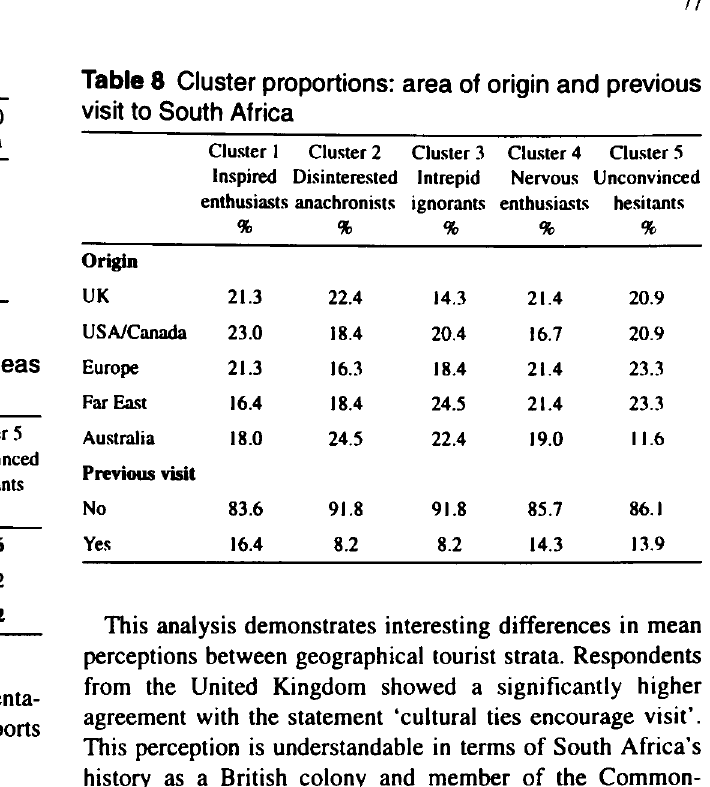
Table 6 Chi-square tests of independence